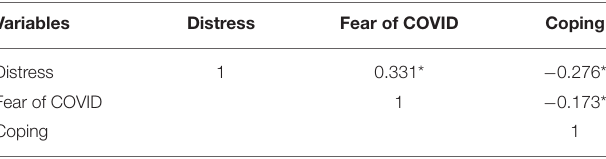
TABLE 5 | Association between psychological distress, coping and fear of COVID-19 using spearman’s partial rank correlation. Variables Distress Fear of COVID Coping Distress 1 0.331* − 0.276* Fear of COVID 1 − 0.173* Coping